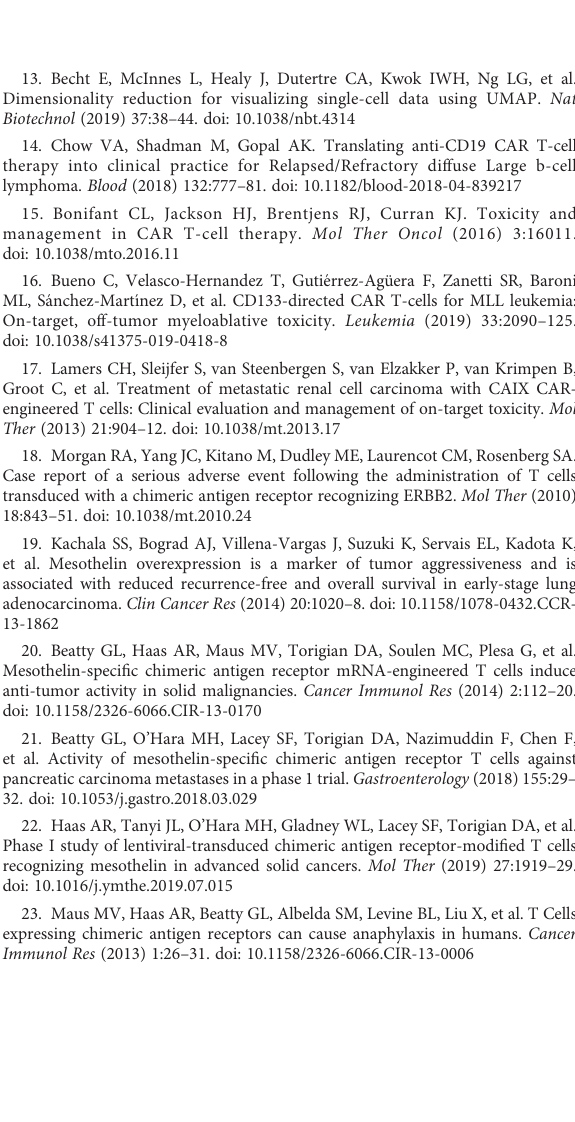
SUPPLEMENTARY FIGURE 1 Af fi nity of anti-MSLN-VHH to human tissues. A. Positive staining of MSLN in the selected tissues (staining brown): stomach, ileum, lung and bladder. B. Negative staining of MSLN in the selected tissues: heart, liver,